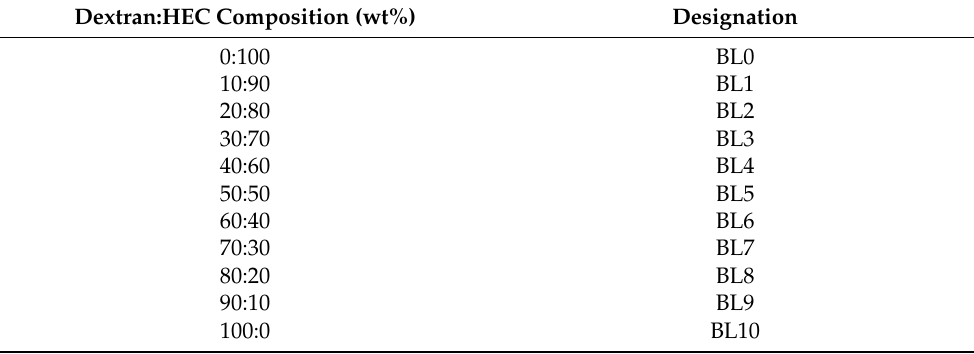
Table 1. Designation for the polymer blend systems and their respective degree of crystallinity.